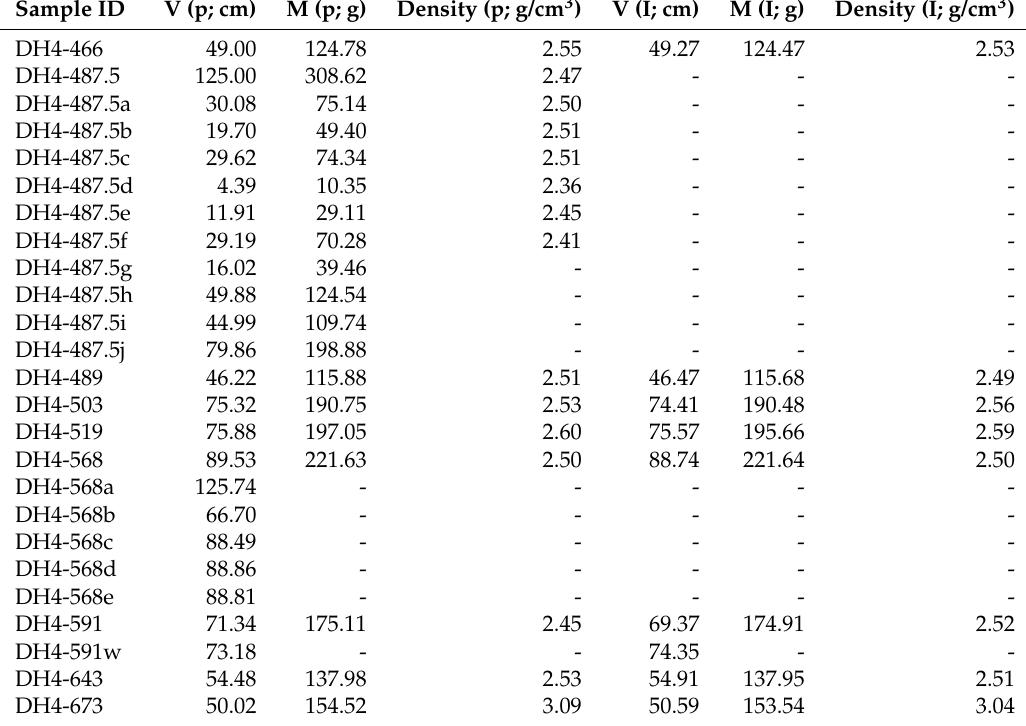
Table 2. Overview of volumes, masses, and bulk densities as derived from the photogrammetric (p) and geotechnical immersion in fluid (I) methods. Refer to the main text for detailed procedures, and see Figure 6 for further